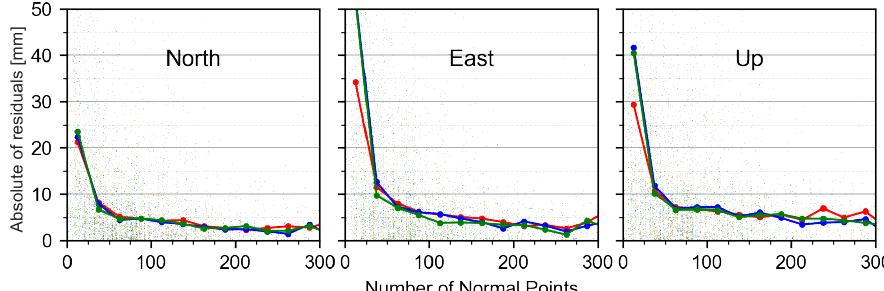
Figure 7. Absolute of residuals of estimated SLR station coordinates based on S3A/B data referred to the a priori values from SLRF2014 as the function of the number of observations collected by all SLR stations for scenario 1 (green), 2 (red), 3